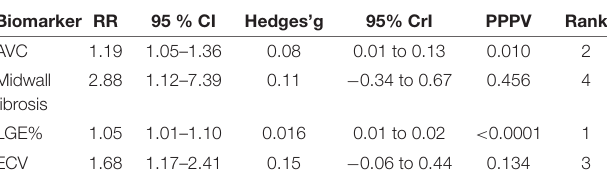
TABLE 3 | Rank of biomarkers according to posterior predictive p -value. Biomarker